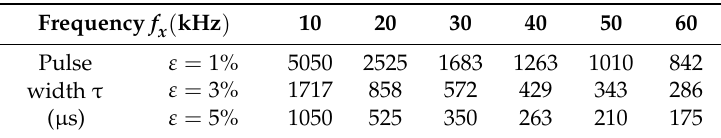
Table 1. Minimum excitation pulse width of accelerometers with different resonant frequencies under undamped conditions.